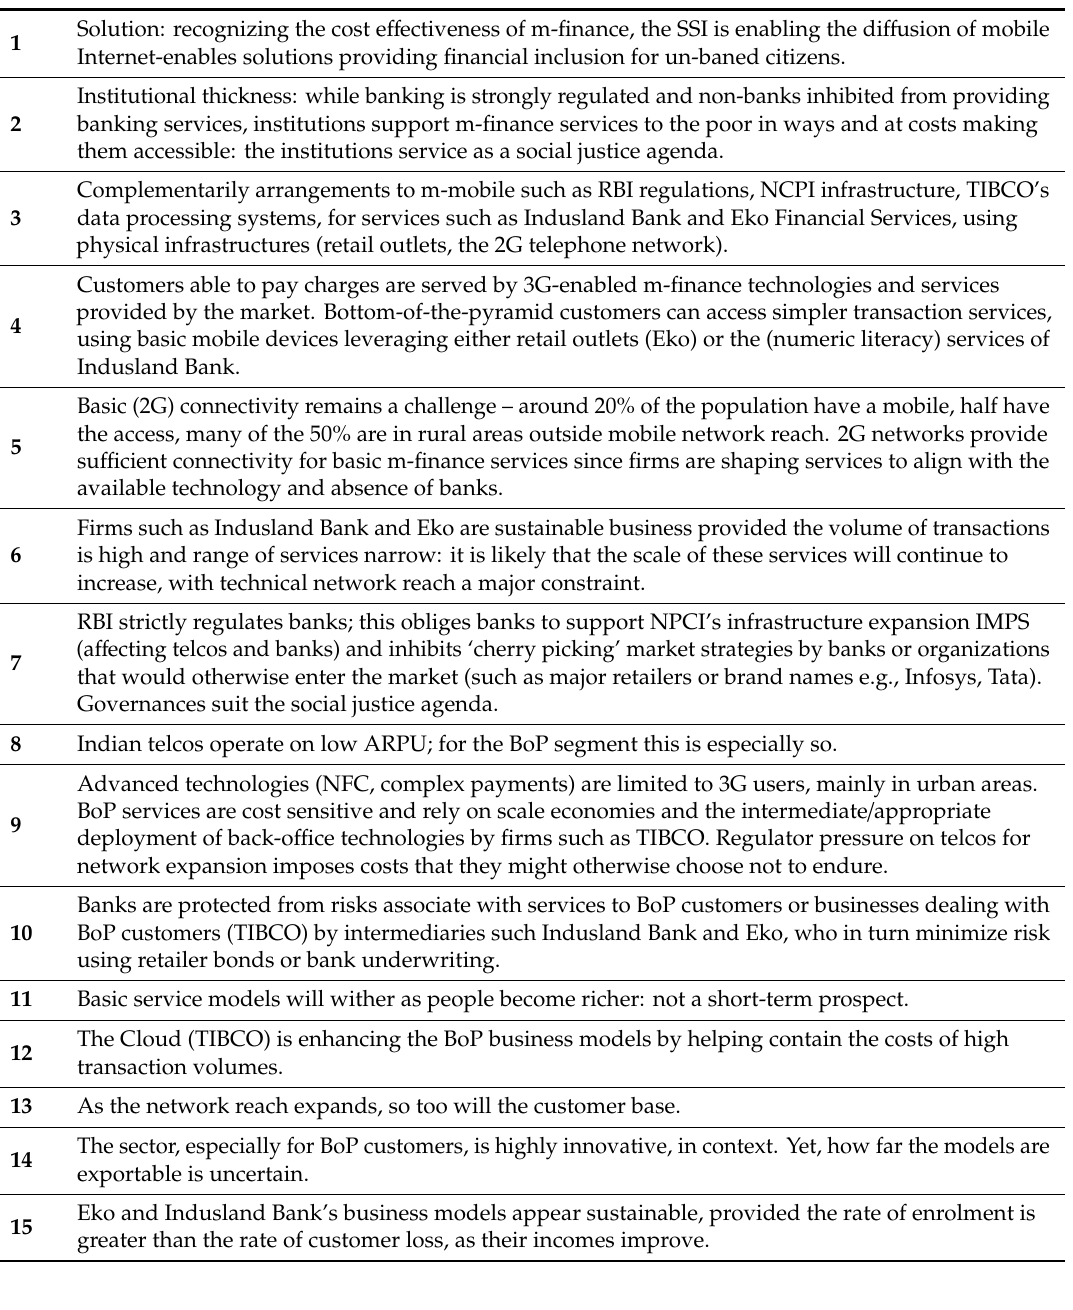
Table 3. Key parameters of the Indian m-payments